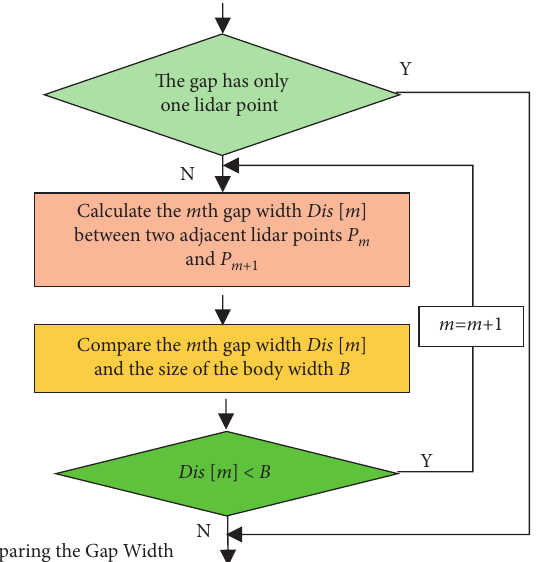
Figure 12: Flowchart of comparing the gap width